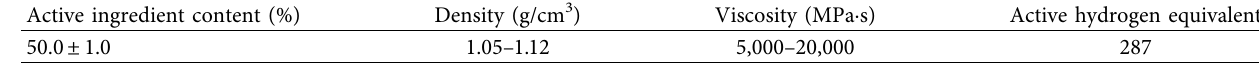
Table 3: Technical properties of the water-based curing agent.